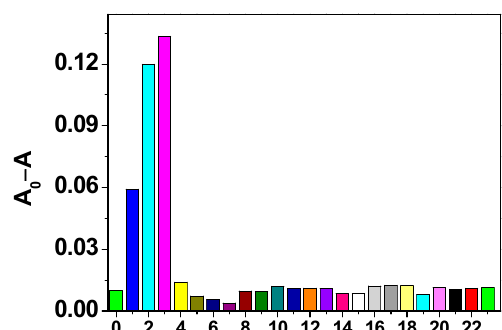
Figure 3. Ultraviolet-visible (UV-vis) absorption spectra of L -Cu 2+ (10 μ M) in the DMF/HEPES mixed solution (7:3, v/v, pH = 7.4) upon addition of various analytes (70 μ M): 0. Blank, 1. Cys, 2. Hcy, 3. GSH, 4. acetylcysteine, 5. thiophenol, 6. sulfide, 7. bisulfate, 8. Val, 9. Ala, 10. Met, 11. Pro, 12. Thr, 13. Trp, 14. Gly, 15. Lys, 16. Phe, 17. Ser, 18. Asn, 19. His, 20. Gln, 21. Leu, 22. Try, 23. Arg. The absorbance values of L -Cu 2+ were recorded at 378 nm.